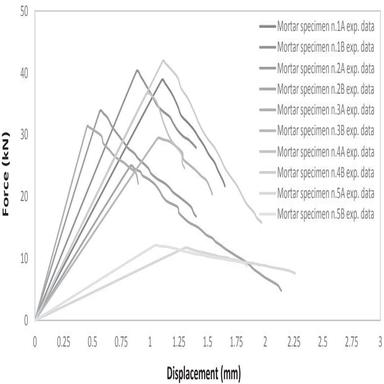
Monotonic load-bearing tests on the mortar specimens.